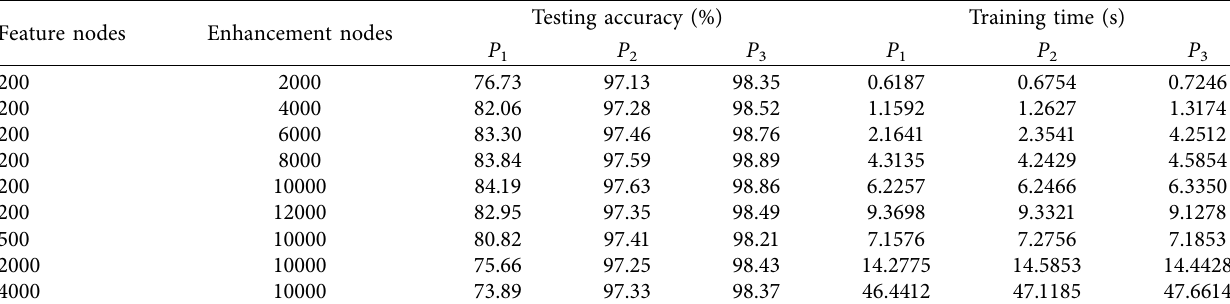
Table 2: The result of adding one feature to BLS.